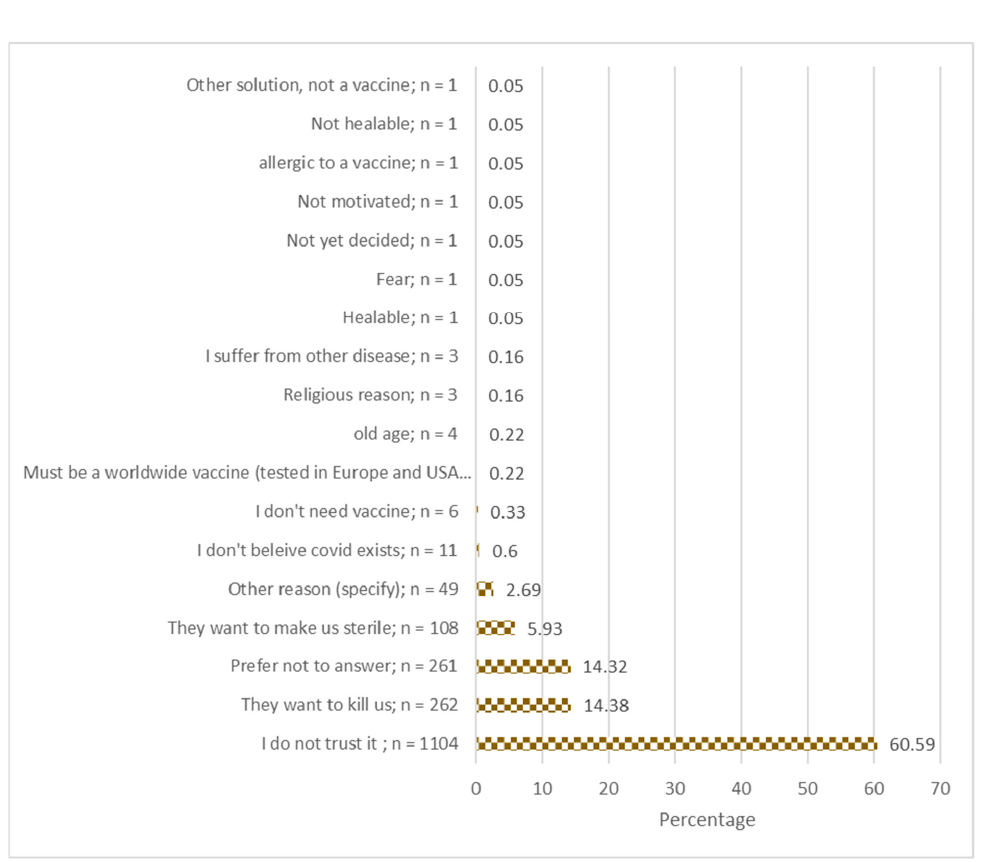
Figure 1. Reasons for COVID-19 vaccine hesitancy; responses of survey participants from seven provinces in the Democratic Republic of the Congo.